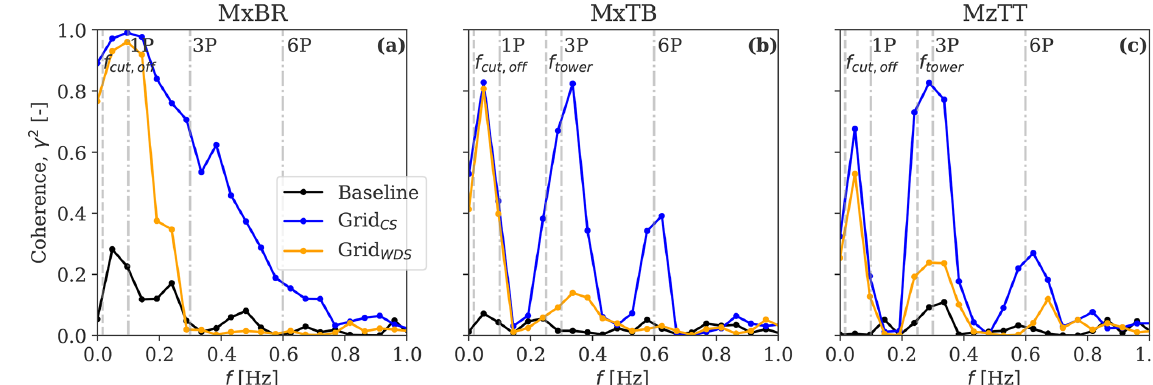
Figure 15. Spectral coherence analysis between the lidar-based load predictions and the target simulations for the (a) blade root flapwise bending moment MxBR, (b) tower-bottom fore-aft bending moment MxTB, and (c) yaw moment MzTT. The target simulations are run for U amb = 6ms − 1 and TI amb = 8%. The baseline’s results are also shown as a solid black line, together with the principal operational frequencies of the wind turbine (1P ≈ 0.1Hz, 3P, and 6P) in dash-dotted grey lines, the dominant frequency of the wake meandering f cut,off ≈ 0 . 016Hz, and the natural frequency of the tower f tower ≈ 0 . 25Hz as dashed grey